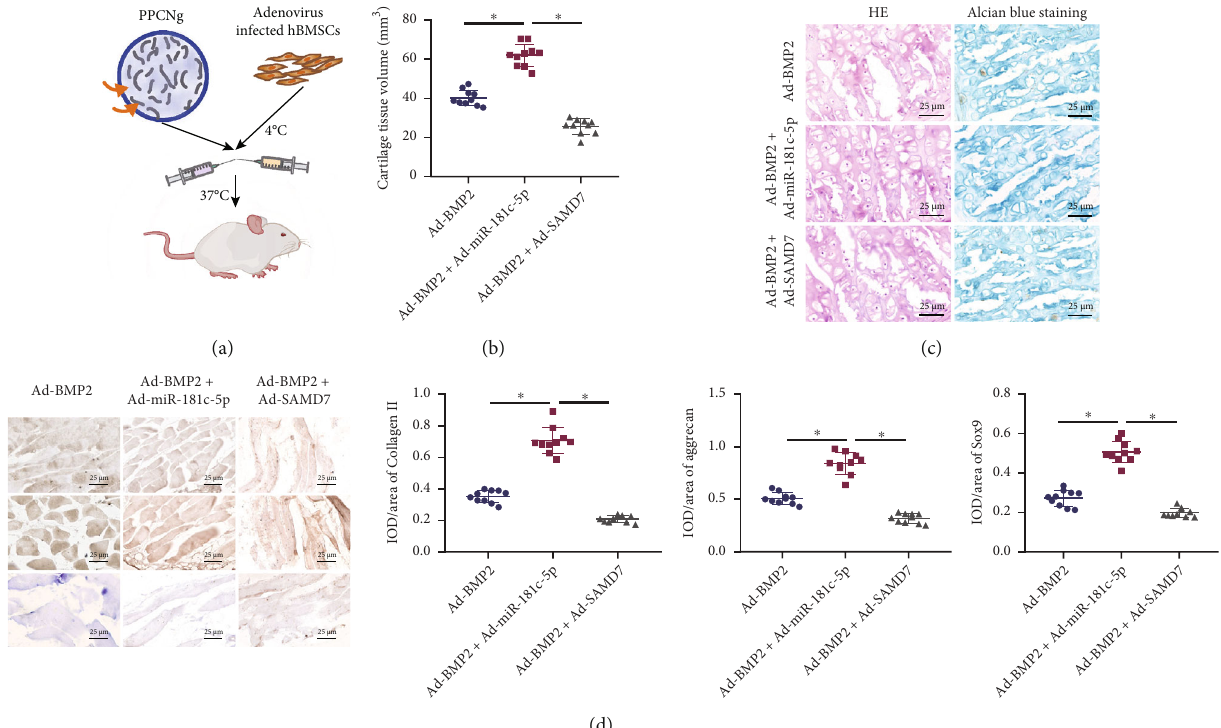
Figure 7: E ff ect of the BMP2/miR-181c-5p/SMAD7 axis on cartilage injury repair in mice. Mice were subcutaneously injected with PPCN-g hydrogel with BMSCs infected with Ad-SAMD7 or Ad-miR-181c-5p ( n = 10 ). (a) Schematic diagram of the application of PPCN-g hydrogel and BMSCs to treat an animal model of ectopic osteogenesis. (b) Micro-CT scan to observe cartilage morphology. (c) Repair of cartilage injury detected by HE staining and Alcian blue staining ( scalebar = 25 μ m ). (d) Expression of collagen II, aggrecan, and Sox9 in cartilage tissues detected by immunohistochemistry ( scale bar = 25 μ m ). ∗ p < 0 : 05